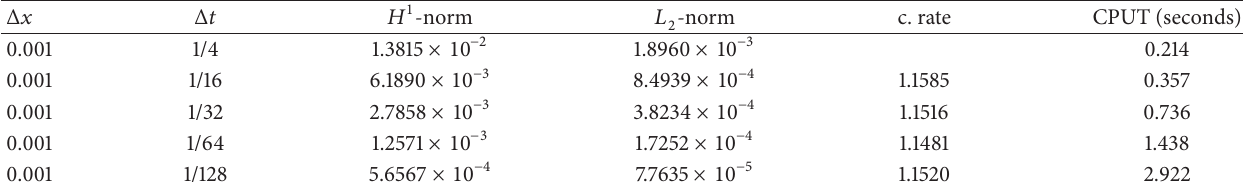
Table 1: Convergence rate in time for (46) with 𝛼 = 0.9 and 𝛽 = 0.5 .